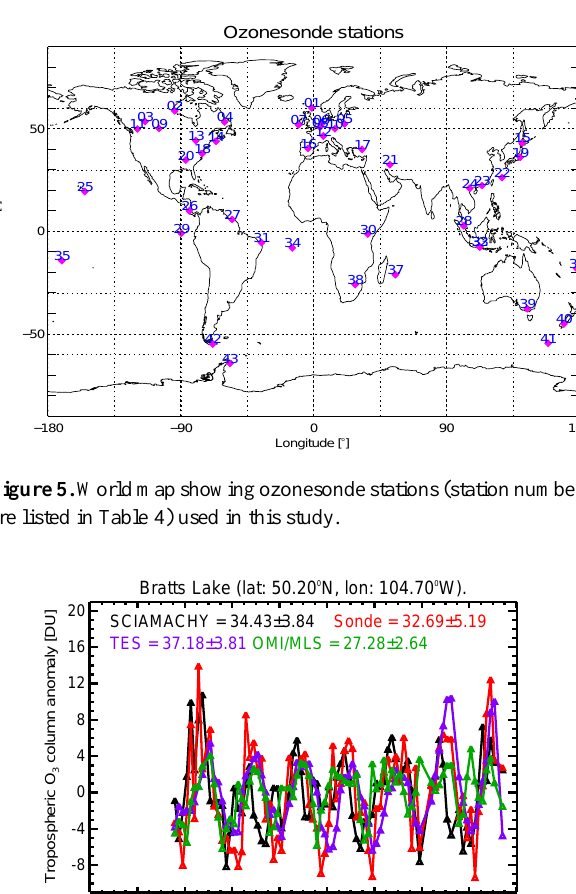
Figure 8. As Fig. 6, but over Hilo (19.72 ◦ N, 155.04 ◦